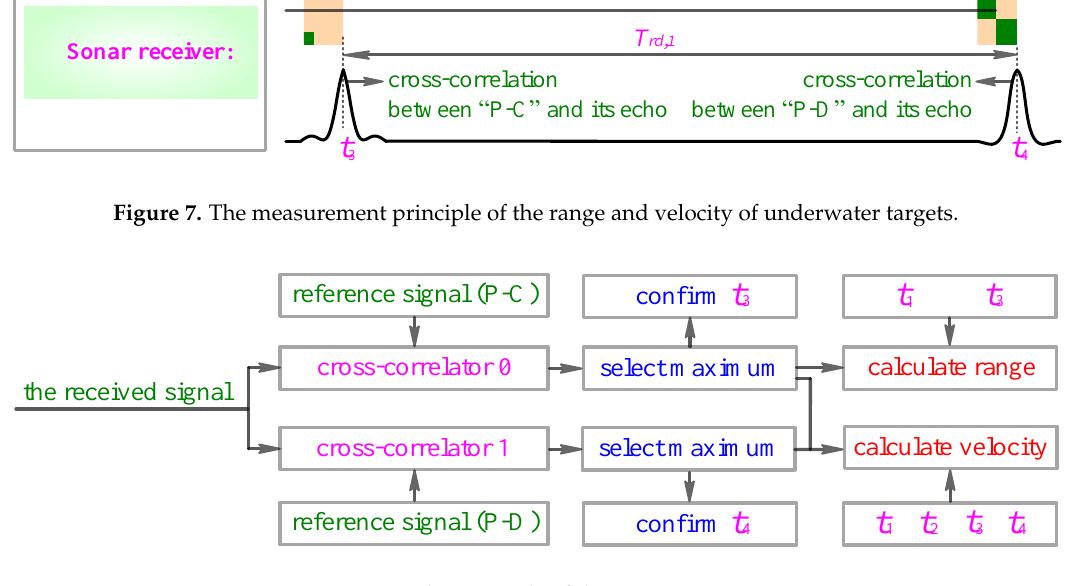
Figure 8. The principle of the sonar receiver.